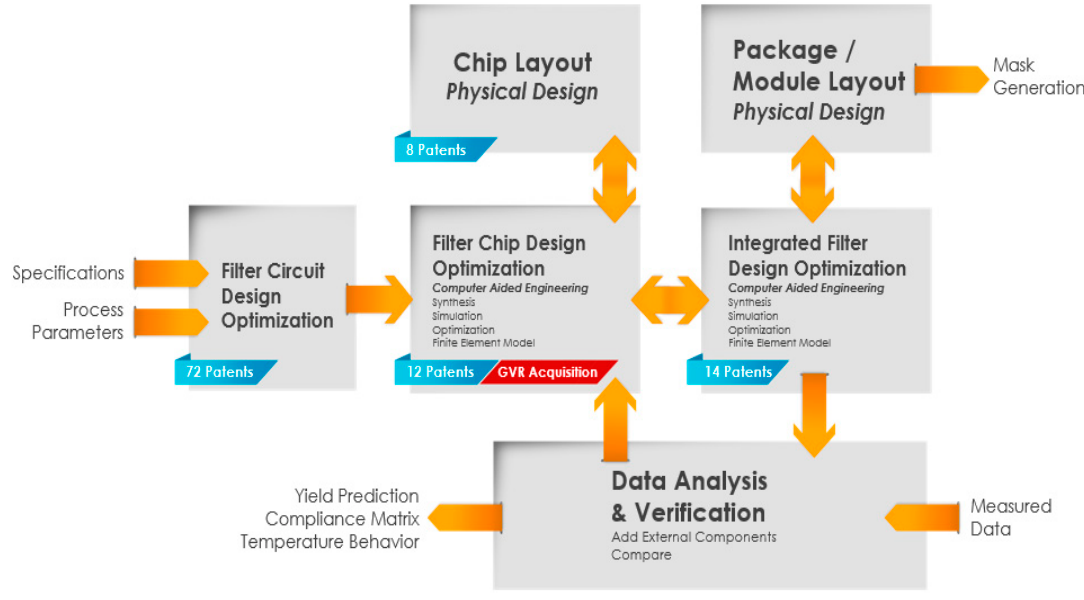
Figure 4. The design procedure for synthesized networks [41].